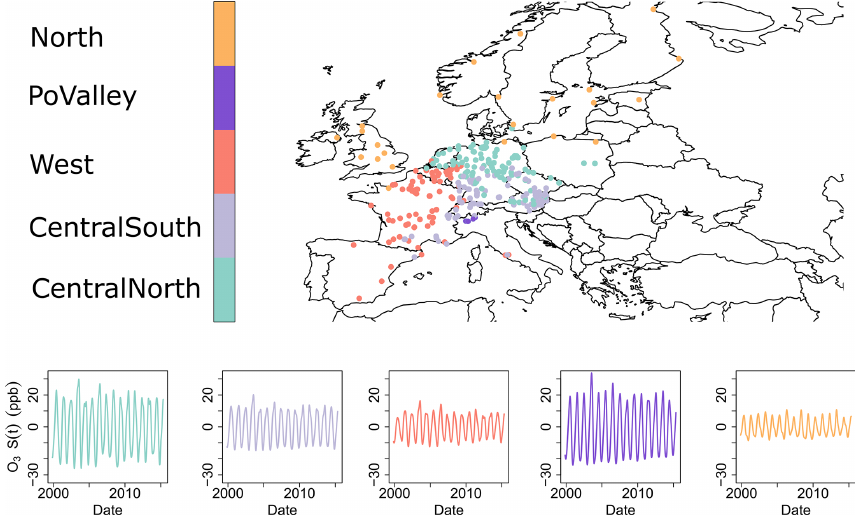
Figure 4. Map with the site clusters derived from daily O 3 S(t) and average S(t) in each site cluster.